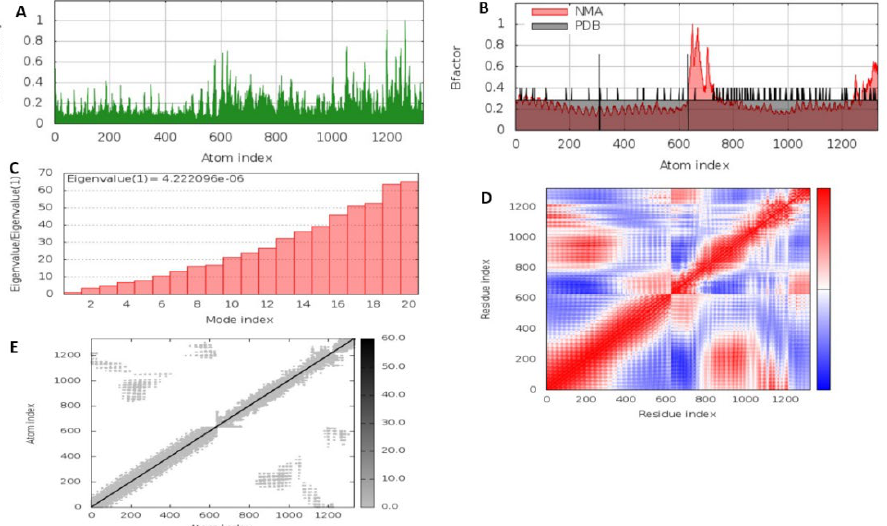
Figure 5. Molecular dynamics with iMODS server. ( A ) Deformability plot. ( B ) B factor plot. ( C ) The eigenvalue of the MEV-TLR complex. ( D ) The covariance matrix between pairs of residues where red, white, and blue represent correlated, uncorrelated, and anti-correlated motion, respectively. ( E ) The elastic network model, with darker gray suggesting more rigid springs.